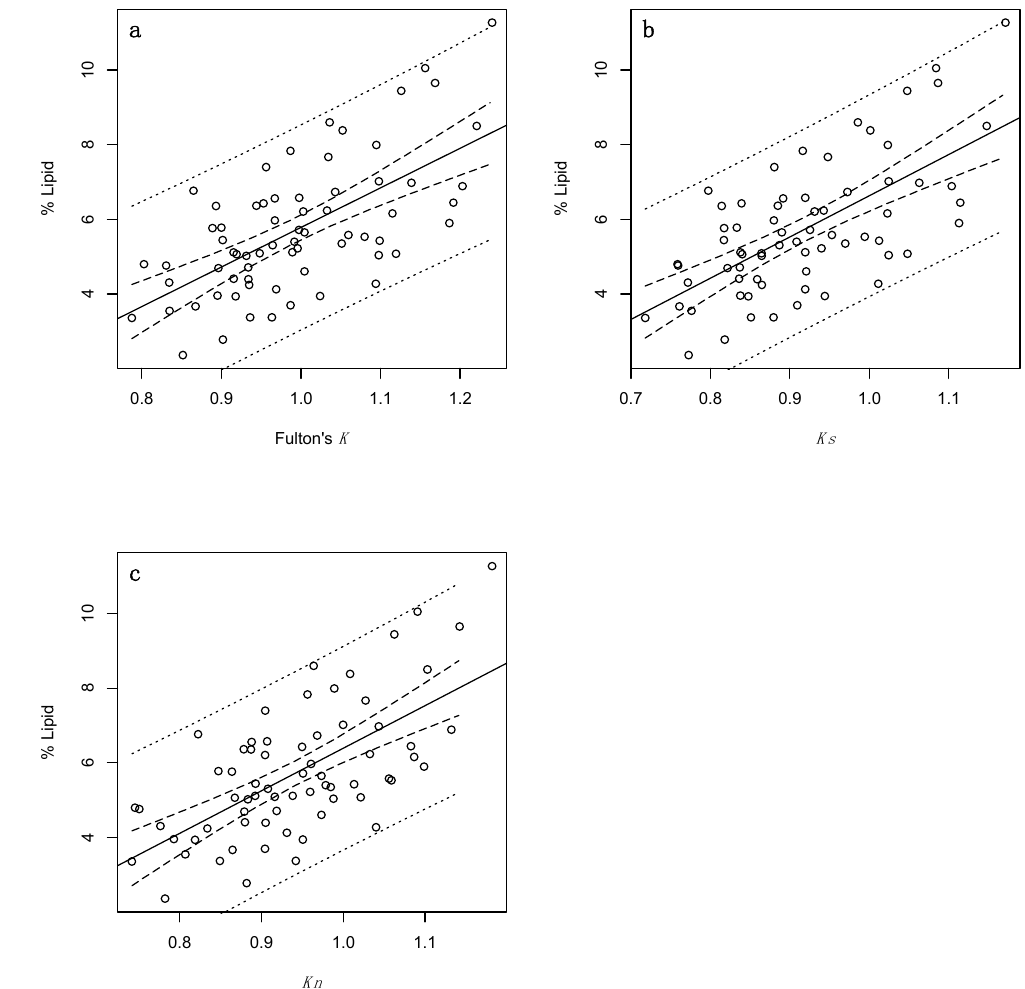
Figure 1. regressions of percent lipid and selected indirect condition indices for adult Cottus cognatus ( n = 68), specifically: ( a ) Fulton’s condition factor (Fulton’s K ); ( b ) Fulton’s condition factor excluding stomach content and gonadal mass ( Ks ); and ( c ) Le Cren’s relative condition factor ( Kn ). Solid lines represent linear regression lines; dotted lines denote 95% prediction intervals; and dashed lines denote 95% confidence intervals. Table 3. linear models ranked to estimate which indirect condition index best approximates percent lipid in adult Cottus cognatus ( n = 68). Fulton’s K = Fulton’s condition factor; Ks = Fulton’s condition factor excluding stomach content and gonadal mass; Kn = Le Cren’s relative condition factor; R 2 = coe ffi cient of determination; RMSE = root mean square error; AIC c = bias-adjusted Akaike Information Criterion for small sample sizes; ∆ AIC c = AIC c of alternative model minus that of the top model; w i = Akaike weight; ER = evidence ratio); LOOCV R 2 = coe ffi cient of determination from cross-validation; LOOCV RMSE = root mean square error from cross-validation. The coe ffi cients of each predictor were significantly di ff erent from 0 ( p = <0.05).